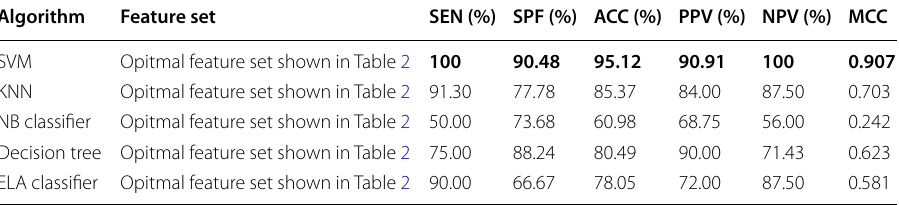
Table 6 Performance indexes for the optimal subset and for each classification algorithm using 10-fold style under normal walking